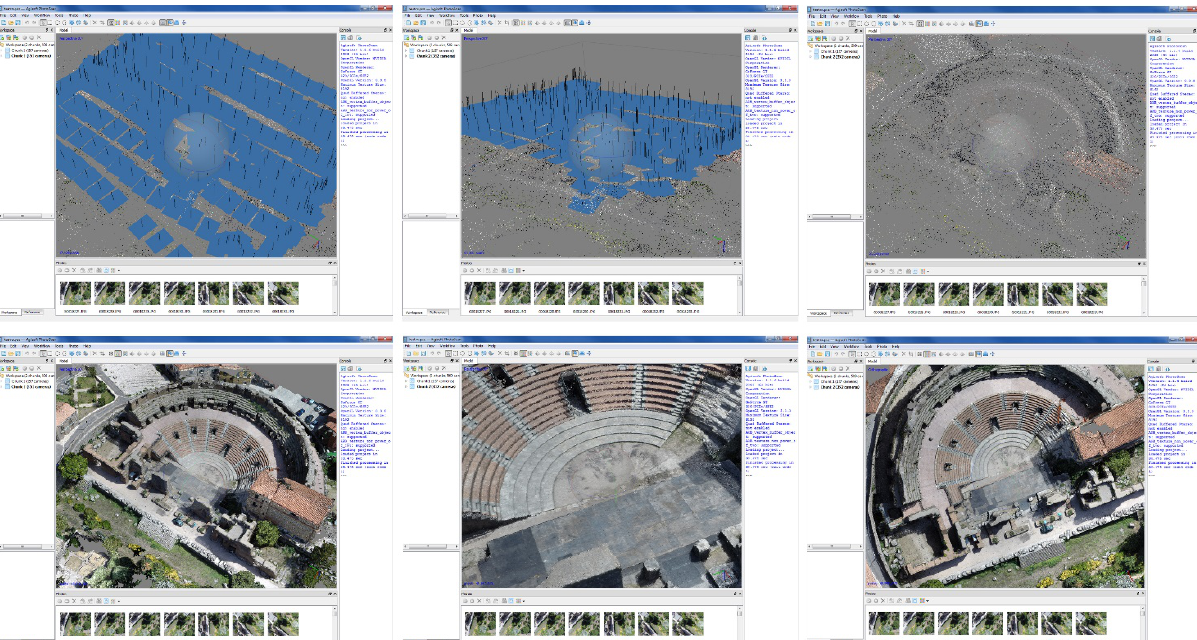
Figur e 5: The post-processing phase was carried out using the Agisoft Photo-Scan